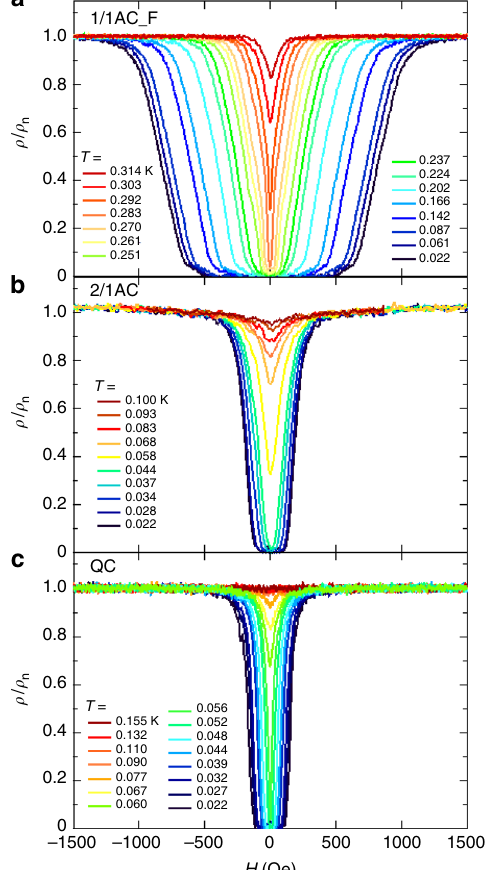
Fig. 9 Magnetoresistance at a constant temperature. Magnetic fi eld dependence of normalized electrical resistivity of the 1/1AC_F sample ( a ), the 2/1AC sample ( b ), and the QC sample ( c ). ρ n denotes the normal state